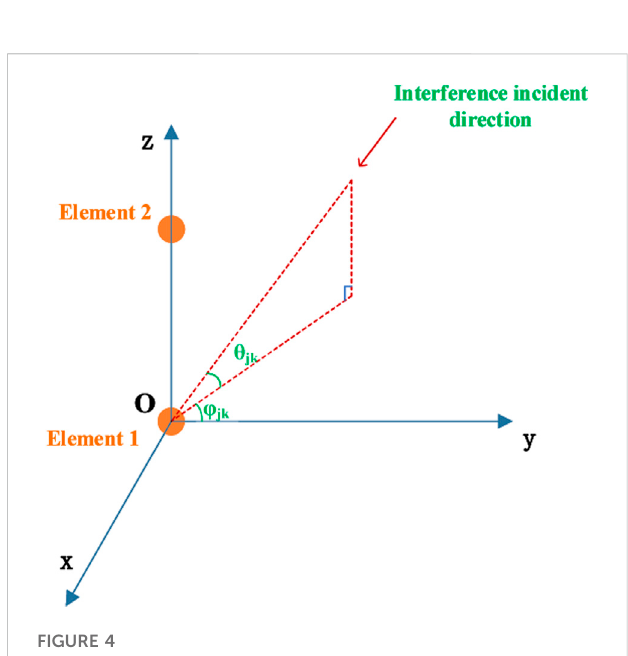
FIGURE 4 Position of two-element array in Oxyz coordinate